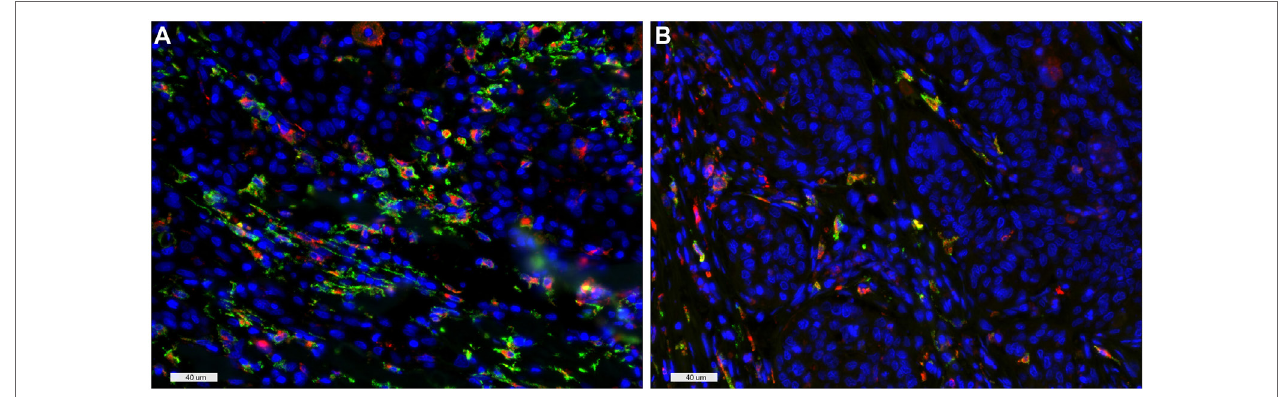
FigUre 4 | CD163 and CD68 double staining of an hrHPV − (a) and hrHPV + (B) case, indicative of M2 macrophage polarization. Colors: green, CD163; red, CD68; and blue, DAPI. Scale bars: 40 µm.